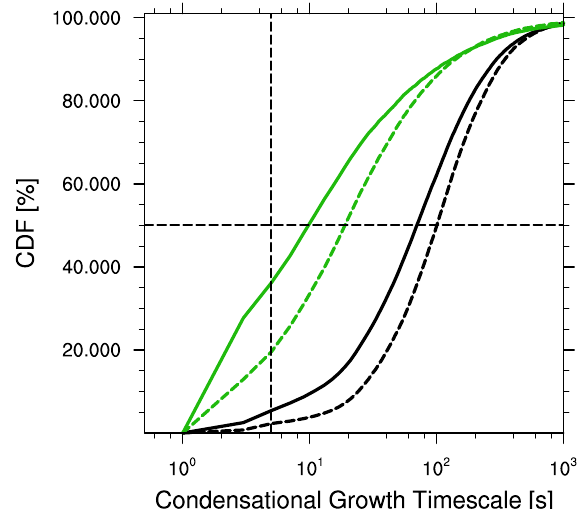
Fig. 15. Cumulative distribution function (CDF) of the condensa- tional growth timescale. The horizontal and vertical dashed lines correspond the the 50th percentile (i.e., median of the distribution) and the model time step, respectively. Colors correspond to those used in Fig. 12. The CDF is computed by analyzing all points from 30 to 120min in the simulations in which cloud water is present and the ambient air is supersaturated (i.e., condensation occurs dur- ing a time step). A lower threshold for the cloud water mixing ratio is imposed (0.01gkg − 1 ) to minimize the effect of outliers on the